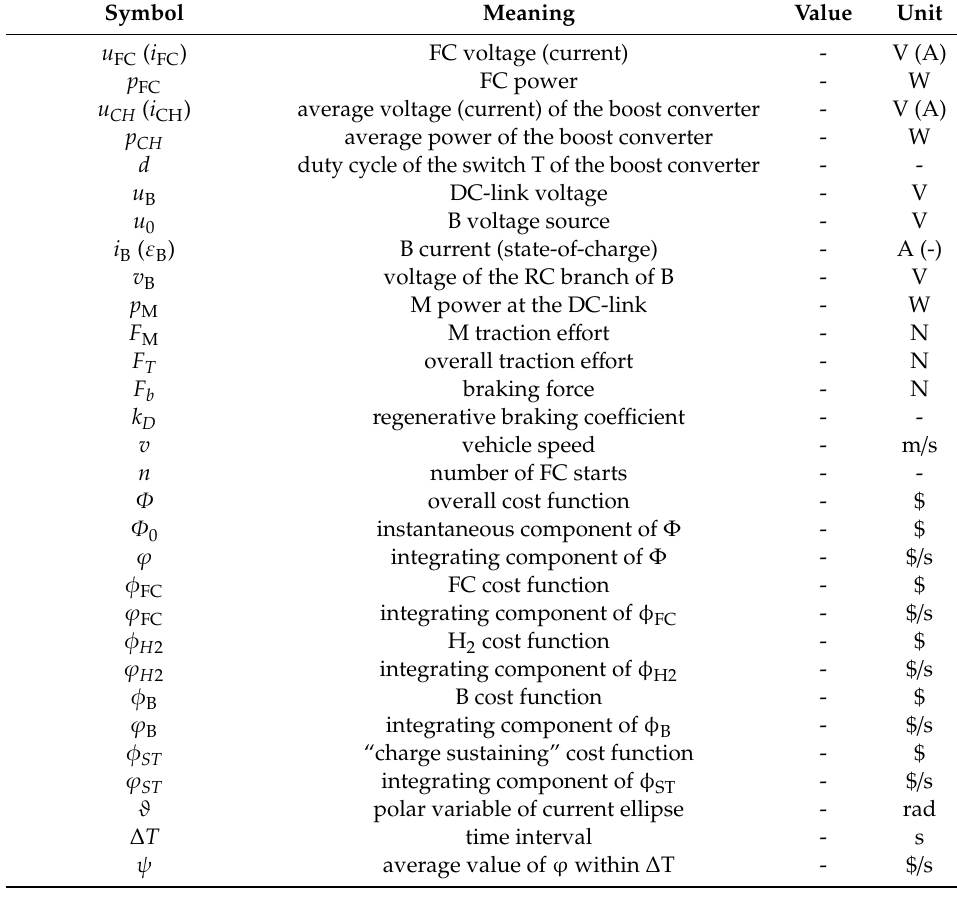
Table A1. List of